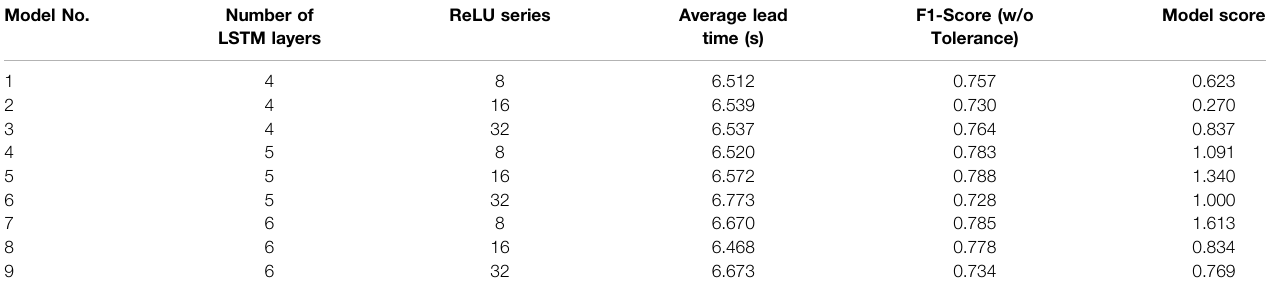
TABLE 2 | The nine combinations of the two hyper-parameters of the LSTM models. The F1 score, average lead time, and model score of these models are also given. Model